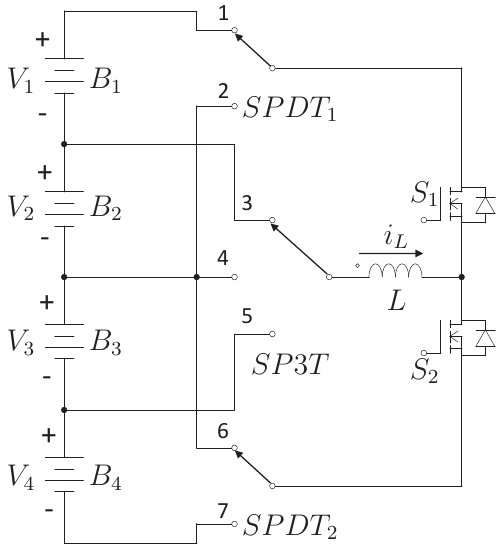
Figure 3. Proposed single-inductor battery equalizer.